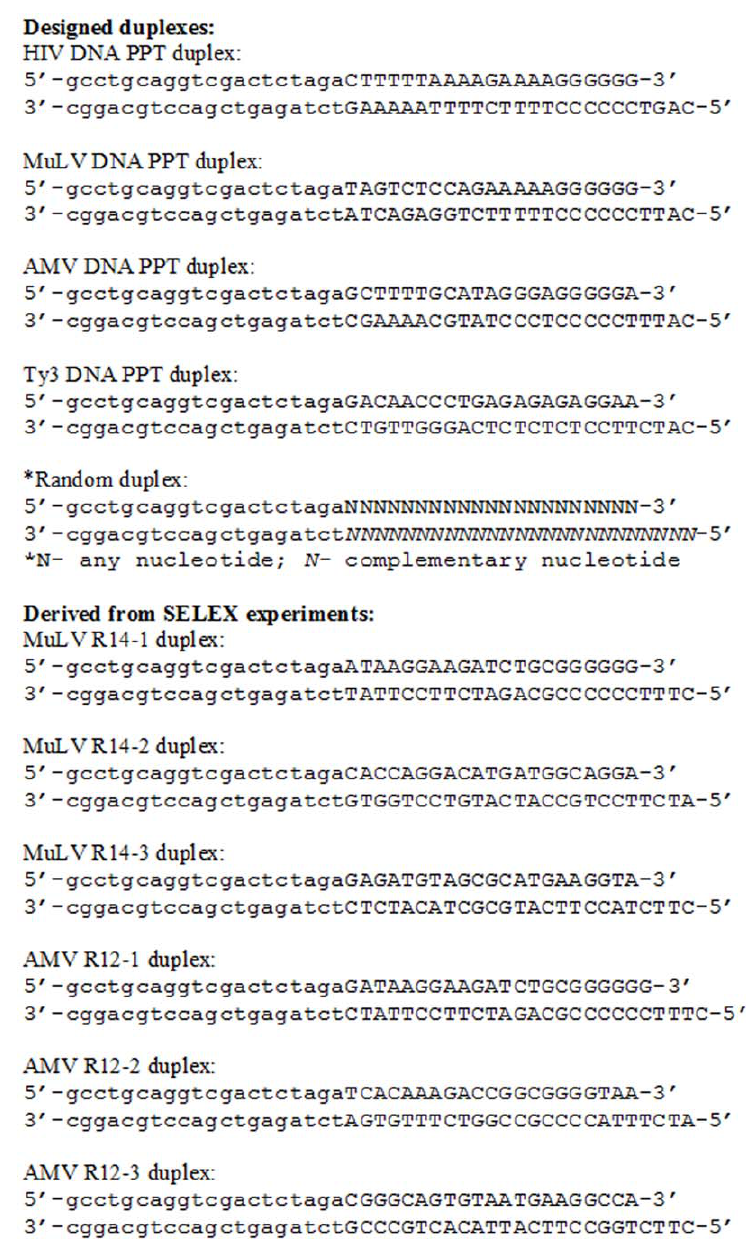
Figure 1. Designed and SELEX selected duplexes tested for binding to RTs. Shown is the sequence of the duplex constructs tested for binding to the various RTs (see Table 1). Each template strand was 45 nts in length while primer strands were 41 nts. All constructs had a four nt 5 9 overhang. Capital letters are sequences that were derived from the PPT containing region of the genome for the particular designed duplex (other than the Random duplex) or those that were selected from the randomized region for the SELEX-derived duplexes. The sequences with small lettering are identical in all the constructs and were derived from the fixed primer region in the primer-template SELEX protocol.